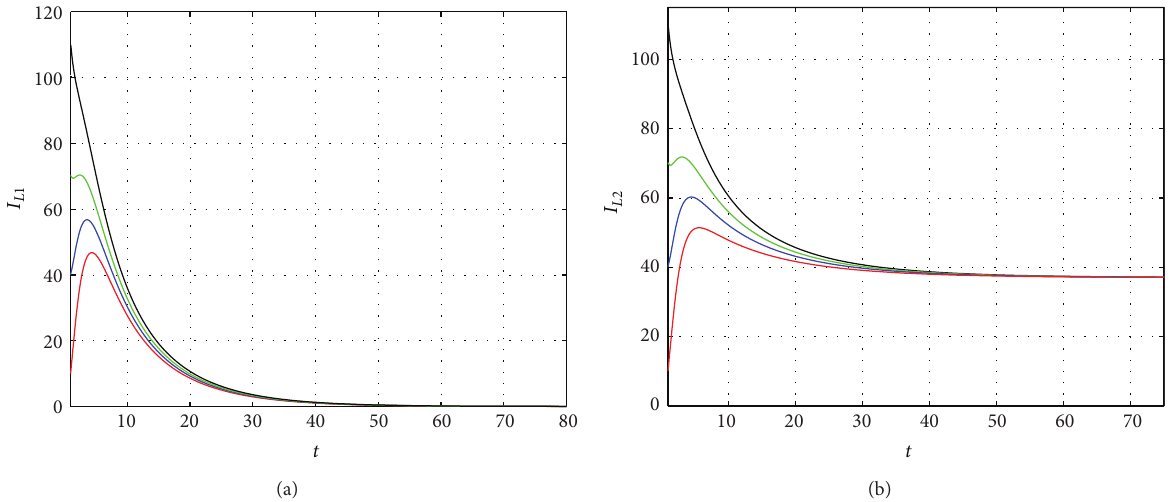
Figure 2: Time series of echinococcosis disease 𝐼 𝐿𝑖 , 𝑖 = 1,2 , when the two patches are isolated for the parameters given in Example 8.